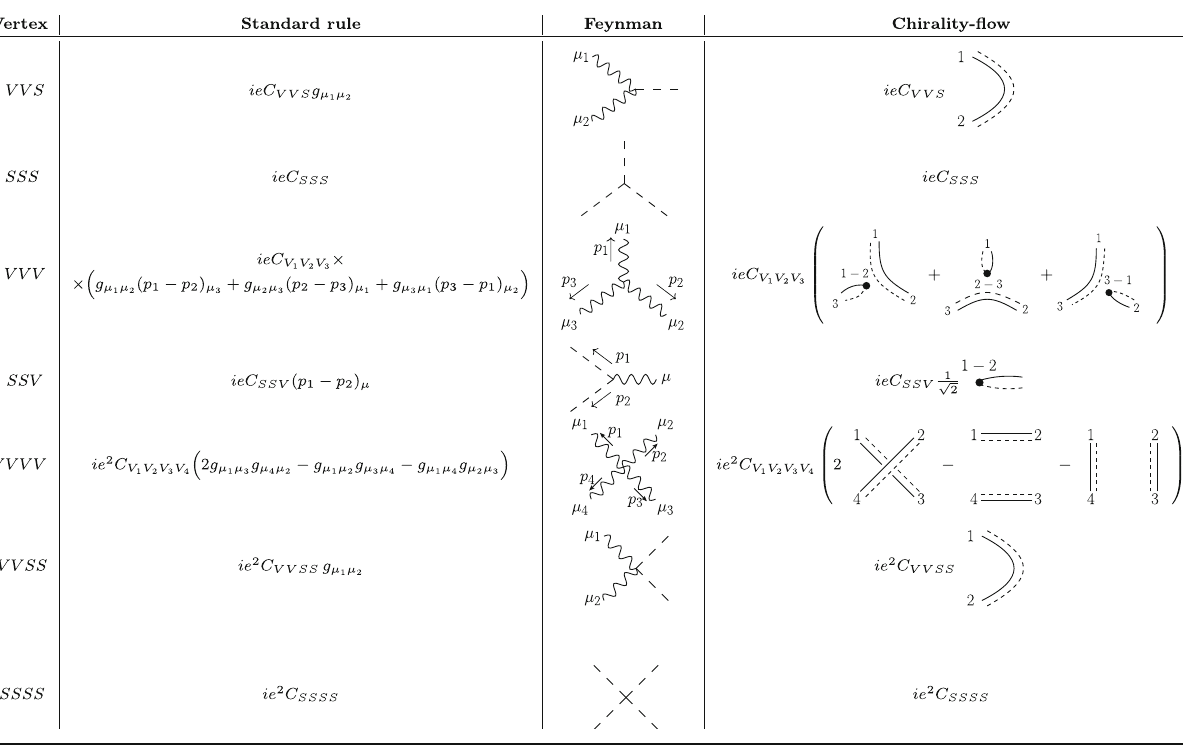
Table 4 Part two of the electroweak “Rosetta Stone”, translating boson vertices from the chirality-flow notation to the standard notation. The coupling constants for every Standard Model process are found in